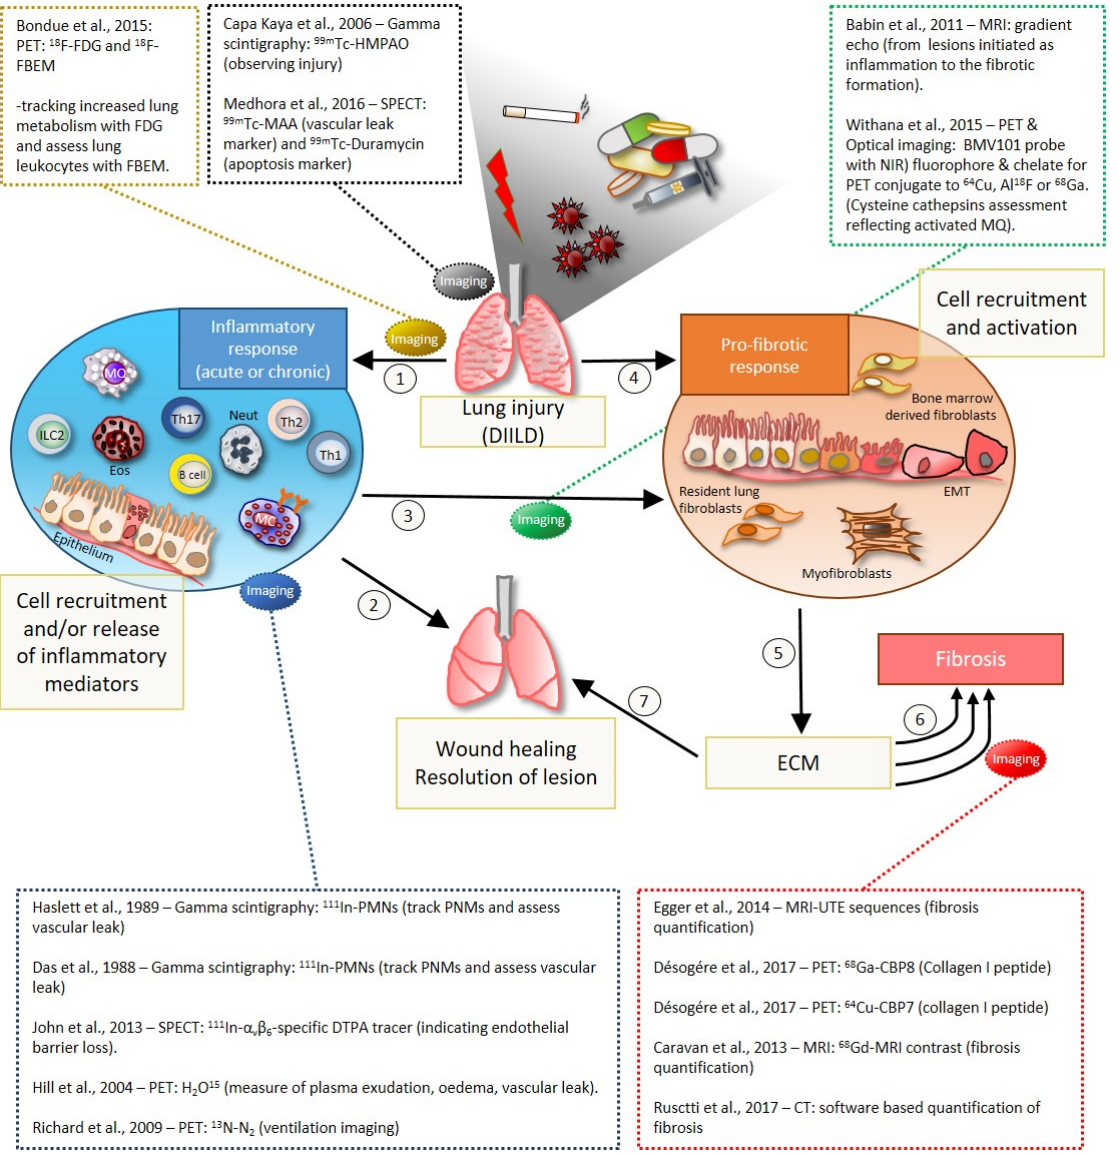
Figure 5. Summary of possible events occurring after drug-induced lung injury or other types of injury exposures, such as cigarette smoke, particle- or infectious agents, or simply mechanical injury. In association with the pathological scenarios that can occur, imaging techniques are used for detecting the lesions at various disease stages. (1) Drug-induced injury might lead to acute or chronic inflammation, involving immune cell infiltration and activation of the epithelium. This primes release of inflammatory mediators from activated epithelial cells and immune cell at the lung tissue injury site. (2) The inflammatory process is triggered in order to resolve and clear the injury, although the inflammation phase commonly leads to initiation of pro-fibrotic events (3). The fibrotic process might also occur directly after drug exposure, without necessarily the initial inflammation phase (4). The pro-fibrotic process might lead to epithelial mesenchymal transition (EMT). In addition, bone marrow derived fibroblasts might increase in the lung during the pro-fibrotic process, as well as resident lung fibroblasts that can transform into myofibroblasts, thus being able to release scar forming mediators and extracellular matrix (ECM) components (5). Elevated levels of ECM products might lead to fibrosis. And, once a stable scar is formed, the lung tissue loses the elastic property, giving rise to symptoms such as breathing difficulties and lung failure (6). If the initial fibrotic lesions can be resolved, then the lung damage can be limited and wound healing occurs in the lung (7). For each phase of DIILD, optimal imaging techniques can be used to assess the rise of lesions or monitor the inflammatory edematous lesion transforming into a fibrotic stable scar. Some of the methods using radionuclide or optical targeted imaging aim to track specific receptors, cells or metabolites, while computed tomography (CT) or magnetic resonance imaging (MRI) rather can be used to map the size and location of induced lesions in the lung.